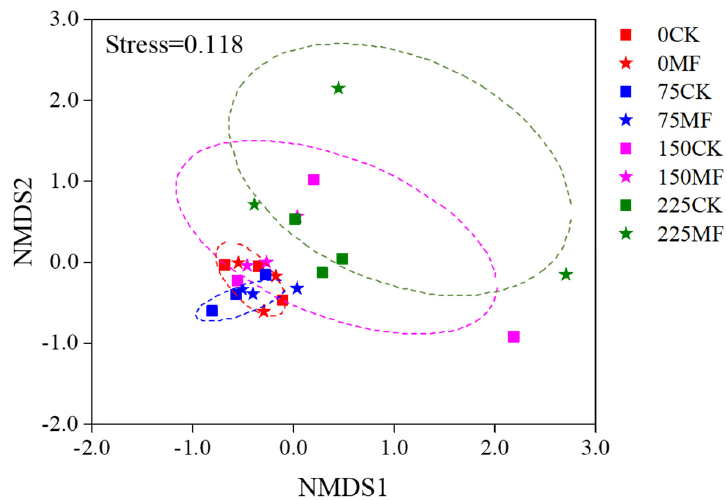
Figure 3. Non-metric multidimensional scaling (NMDS) plot of the AM fungal communities in maize roots under different salinity levels. Red symbols: 0 NaCl, blue symbols: 75 NaCl, purple symbols: 150 NaCl, and green symbols: 225 NaCl. Square: CK, Pentagram: MF inoculated treatment. Ellipses represent 95% confidence intervals around the centroid of all samples.